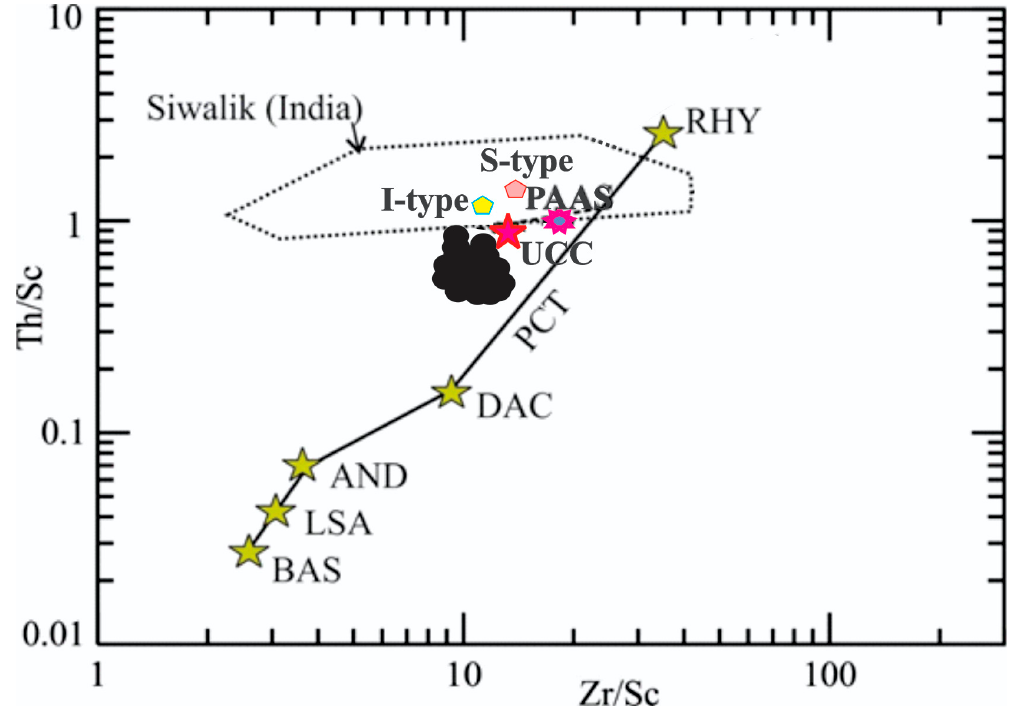
Figure 8. A Th/Sc versus Zr/Sc plot [53] for the Brahmaputra River sediments. Stars: BAS (basalt), LSA (low silica andesite), AND (andesite), DAC (dacite) and RHY (rhyolite) are average volcanic rock compositions (as plotted by Roser and Korsch [54]). PCT—primary compositional trend. Field for the Siwalik Group, NW Himalaya, India [39]. Brahmaputra River sediment samples are represented by the black dots.